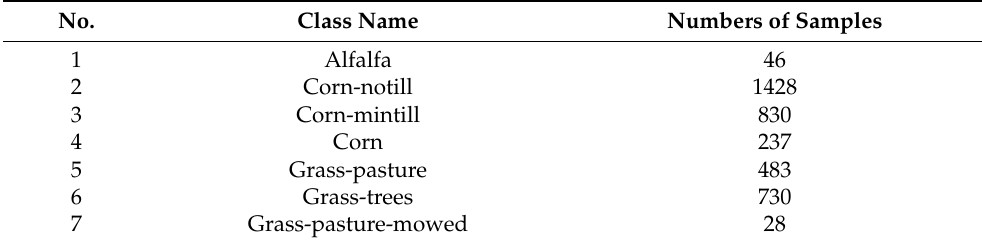
Table 1. Land cover class information for the IN